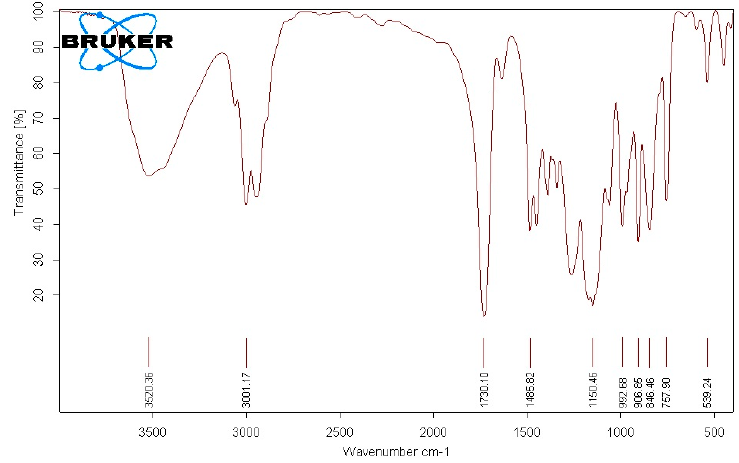
Figure 5. BNC-GMA MS = 1.8 FT–IR spectrum: cellulose profile plus GMA appendages.